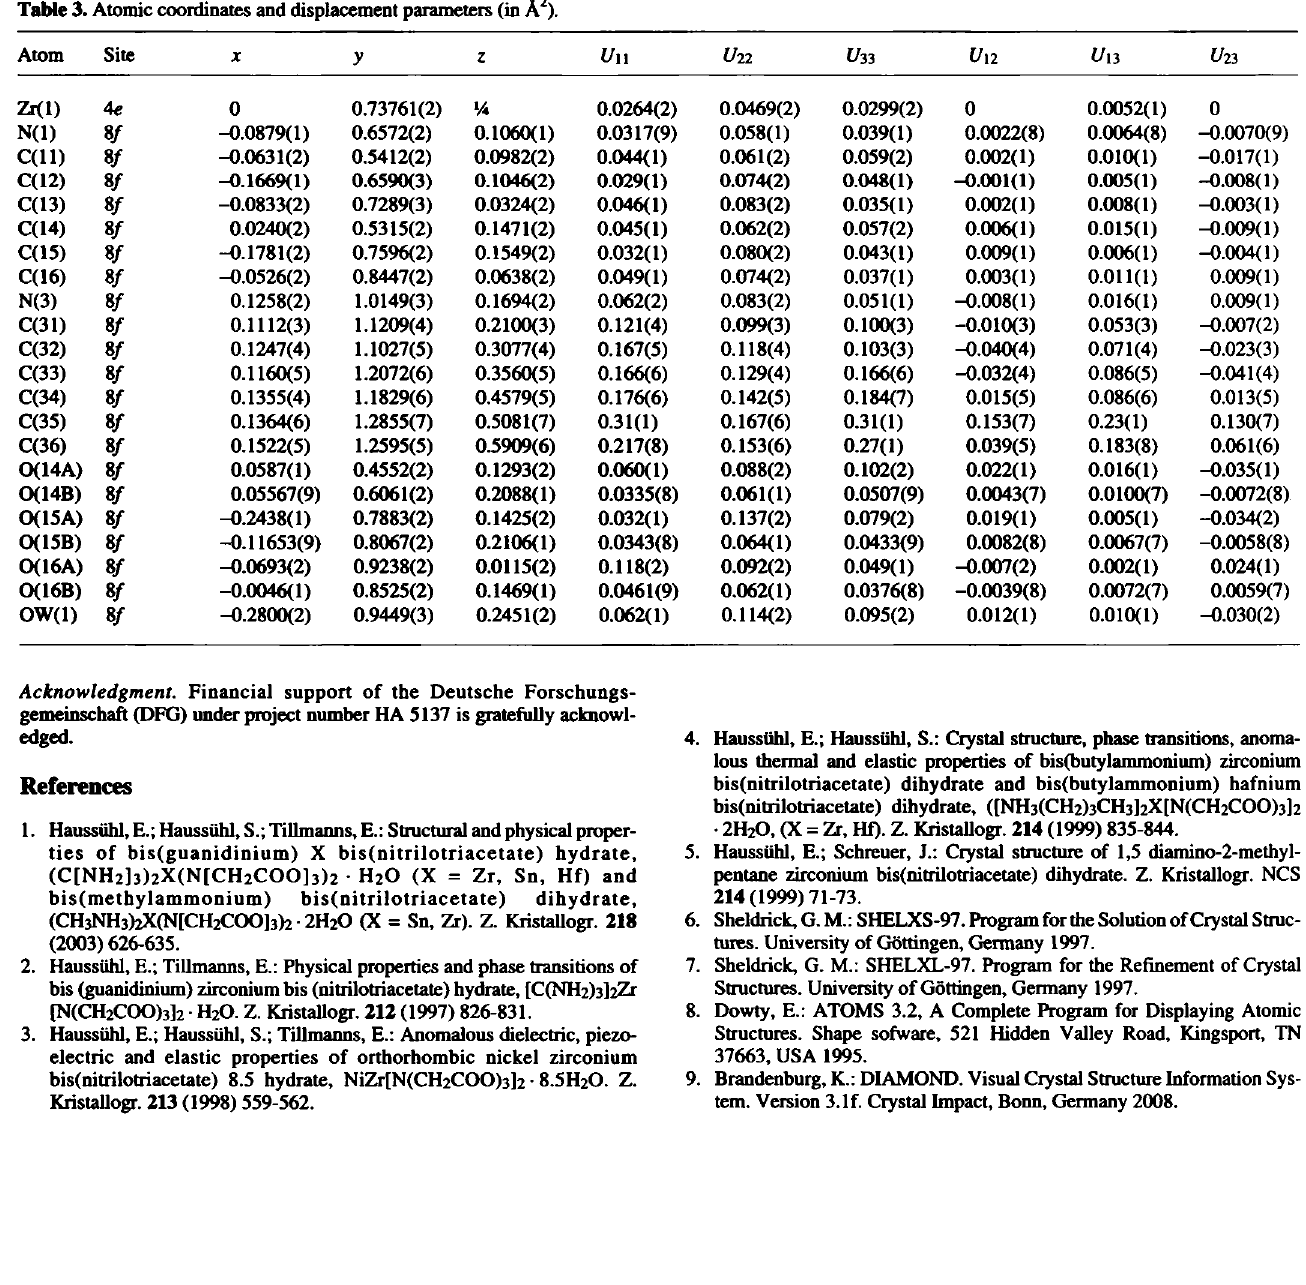
Table 2. Atomic coordinates and displacement parameters (in Â 2 ).